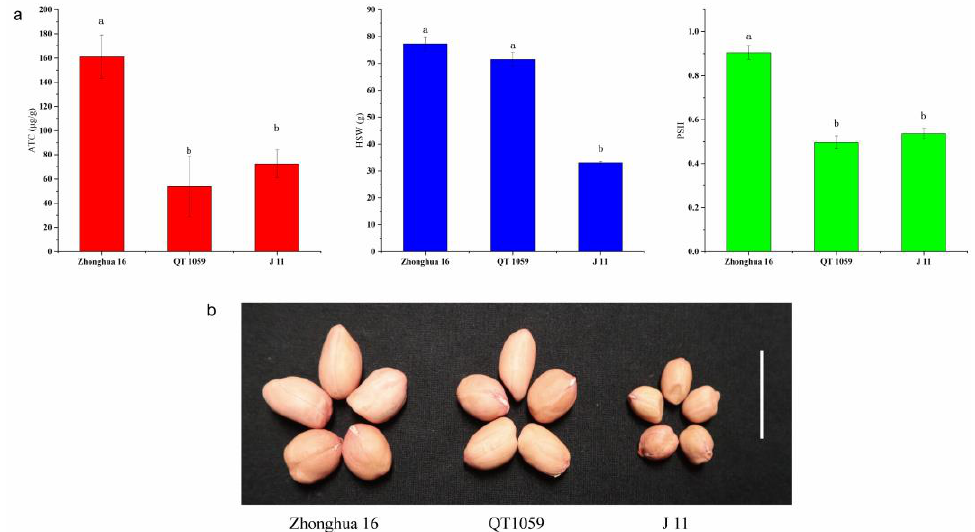
Figure 2. Phenotypic characterization of seeds from ‘Zhonghua 16’, ‘QT 1059’ and ‘J 11’. ( a ) Comparisons of ATC, HSW and PSII among ‘Zhonghua 16’, ‘QT 1059’ and ’J 11’. Histogram represented mean ± s.d. ( n = 9 for ATC and PSII, n = 3 for HSW). Different letters in the graph mean the values are statistically different at p < 0.05 based on LSD mupltiple comparison. ( b ) Seed morphology of ‘Zhonghua 16’, ‘QT 1059’ and ‘J 11’. Scale bar: 2 cm. ATC aflatoxin content, HSW hundred seed weight, PSII percent seed infection index.